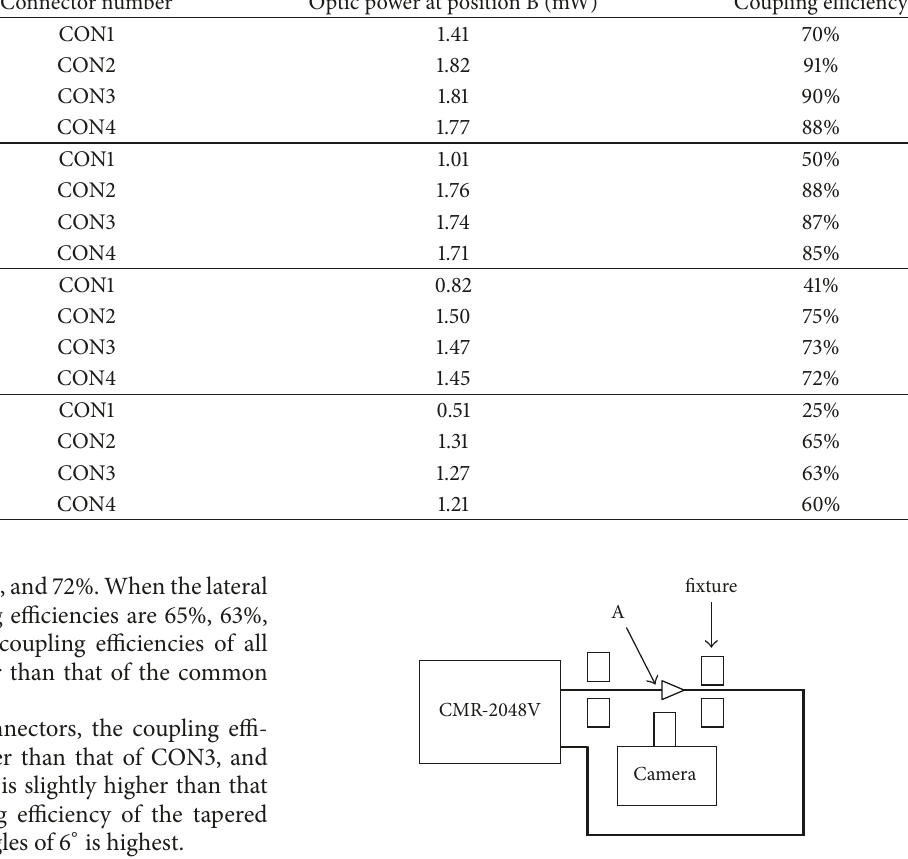
sensitivity is from 0 dB to − 43 dB. The bit rate of the digital signal is 2048 Kb/s. The coding mode is HDB3. Test data frame has two types, which are nonframing and frame. For the frame modes, there are PCM30, PCM30CRC, PCM31, and PCM31CRC for choice [10,